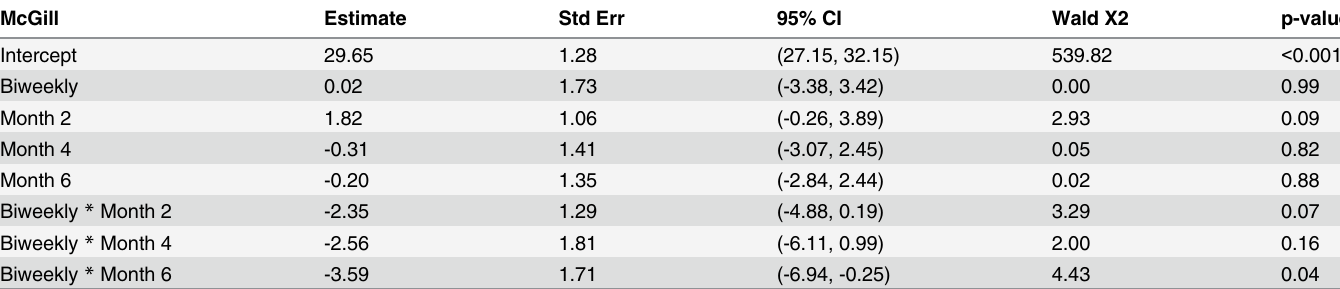
Table 4. Estimates and accompanying statistical values from the GEE modeling of the outcome McGill Pain